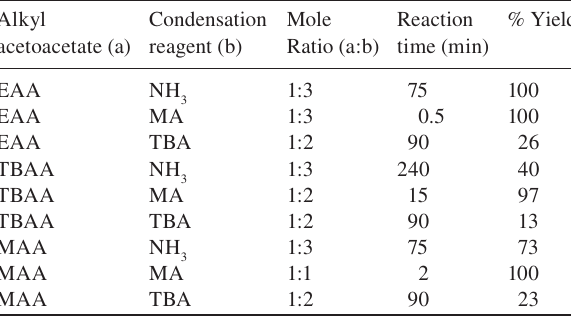
Table 1 Summary of batch experiments for the synthesis of β -amino crotonates at 20 °